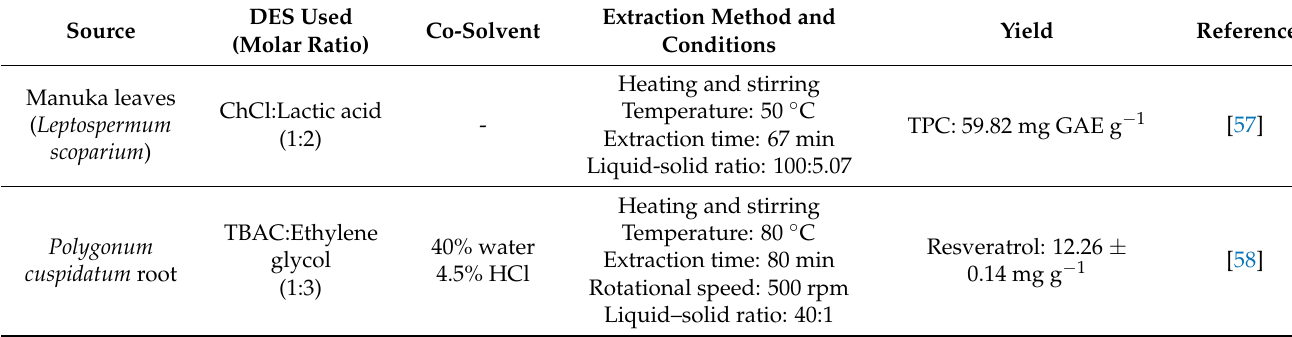
Table 2. Phenolic compound extraction processes presented in this